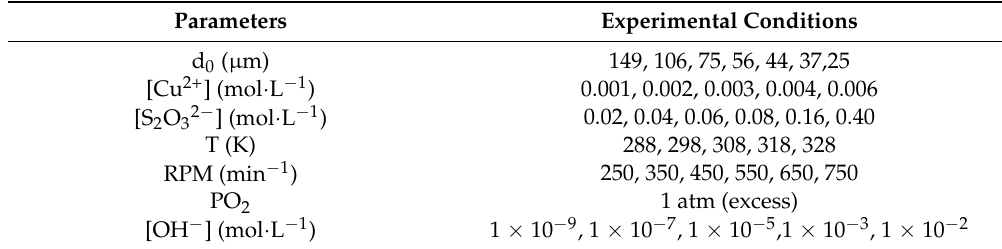
Table 1. Experimental conditions of the kinetic study.